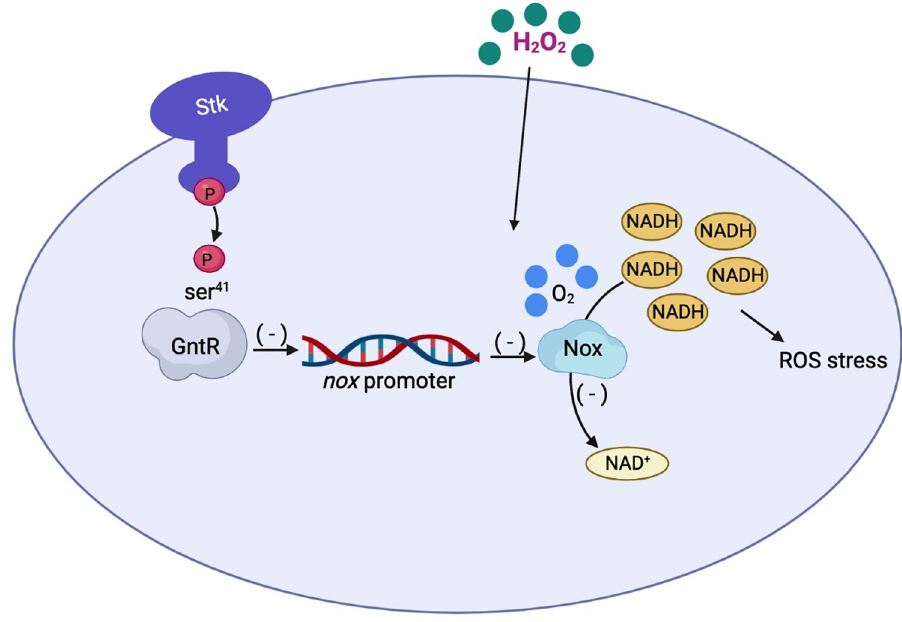
Fig 6. Proposed model for STK/GntR pathway that the impacts on oxidative stress and intracellular survival mechanisms in S . suis exposed to an oxidizing environment.